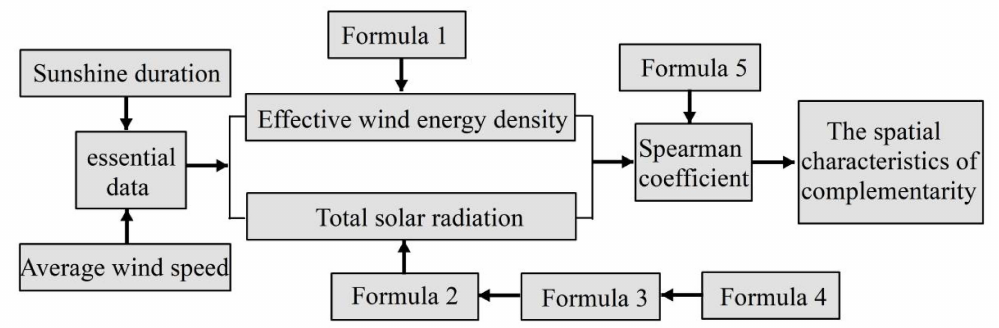
Figure 2. Flow chart of research